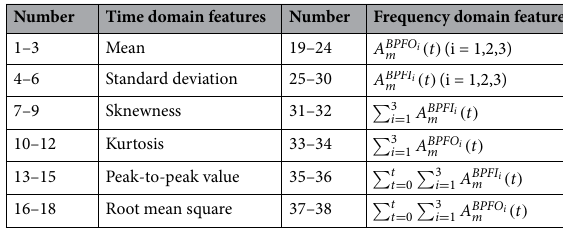
Table 4. Extracted features for bearing RUL prediction.